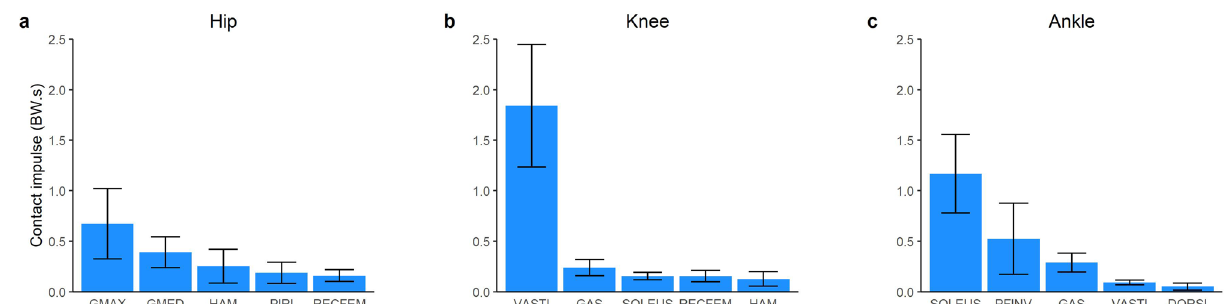
Figure 7. Mean (bars) and SD (error bars) musculotendinous contributions to the bodyweight (BW) normalised joint contact impulse across the landing phase (initial contact to peak knee flexion) of a single-leg drop landing from a 0.31 m height. GMAX, gluteus maximus; GMED, gluteus medius (sum of gluteus medius and minimius); HAM, biarticular hamstrings (sum of biceps femoris long head, semimembranosus, and semitendinosus); PIRI, piriformis; RECFEM, rectus femoris; VASTI, vasti (sum of vastus intermedius, lateralis and medialis); GAS, gastrocnemius (sum of lateral and medial gastrocnemius); SOLEUS, soleus; PFINV, plantar flexor invertors (sum of tibialis posterior, flexor hallucis and digitorum longus); DORSI, ankle dorsiflexors (sum of tibialis anterior, extensor hallucis and digitorum